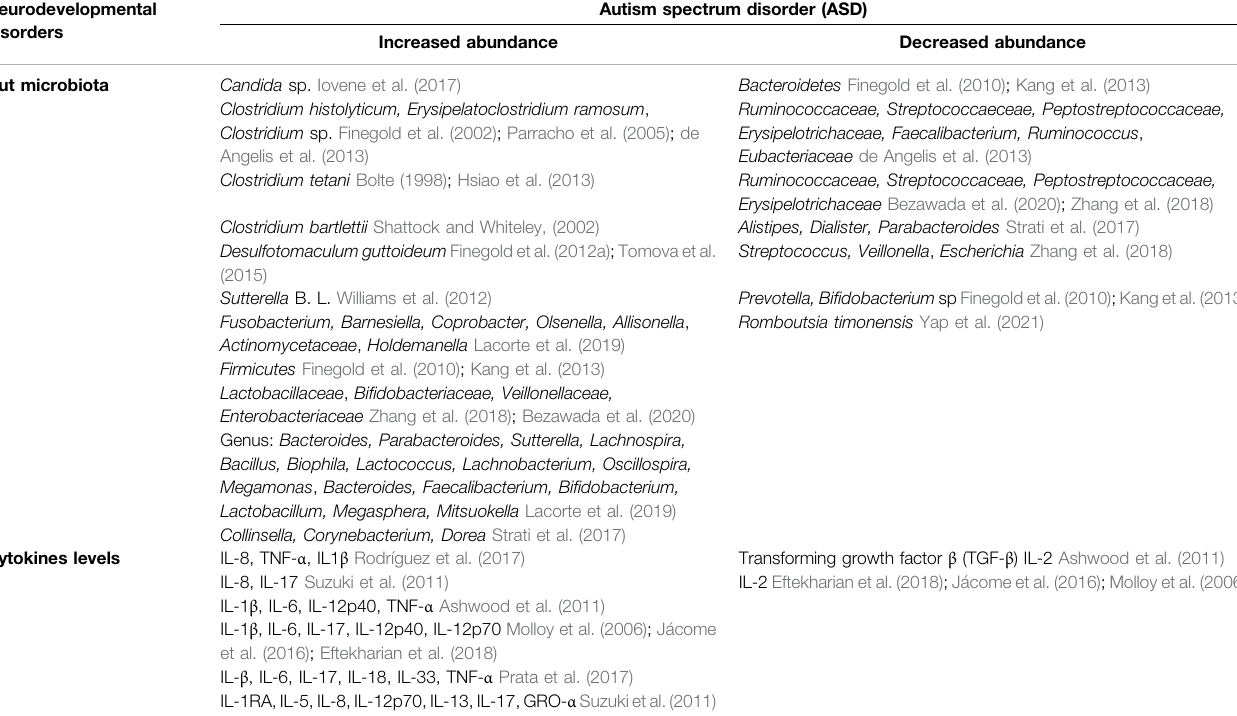
TABLE 1 | Gut microbes and Level of cytokines in autism spectrum disorder (ASD). Neurodevelopmental